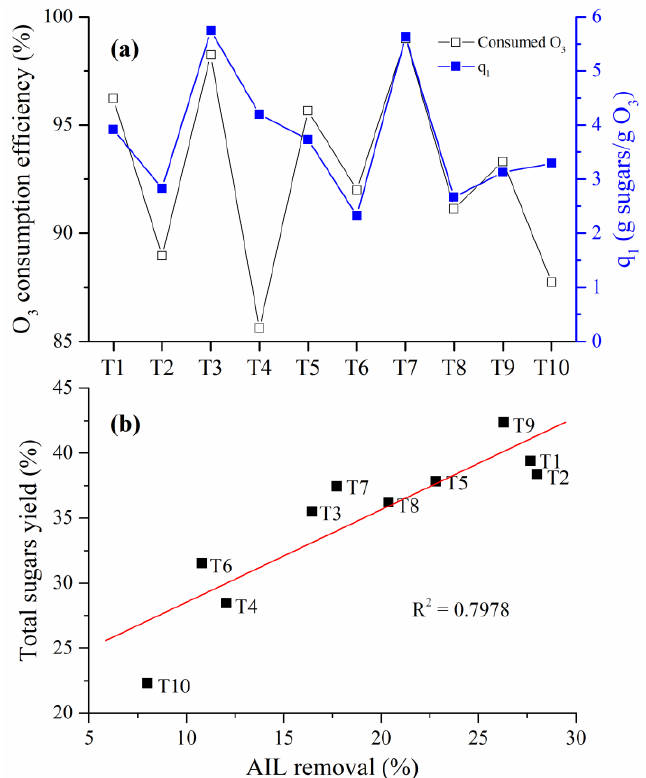
Figure 4. ( a ) Ozone consumption efficiencies and sugars released to expended ozone ratio ( q 1 ) at different experimental conditions. Note: The amount of sugars is the sum of glucose and xylose contents. ( b ) Relationship between total sugars yield (glucose and xylose) and AIL removed.